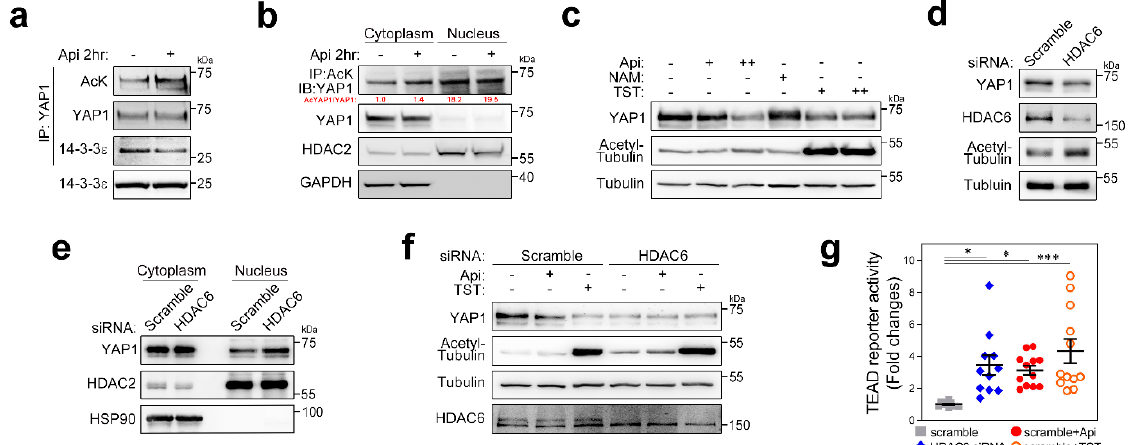
Figure 3. Acetylation governs YAP1 shuttling into the nucleus. ( a ) Apicidin induced acetylation on YAP1. Short-term (2 h) incubation of YAP1 augmented the acetylation level of YAP1 without alteration of YAP1 amounts, which allowed dissociation of YAP1 from the 14-3-3 molecule that tethered YAP1 in the cytoplasm. ( b ) YAP1 acetylation in response to 2 h of treatment with apicidin took place in the cytoplasm, but most acetyl-YAP1 was enriched in the nucleus. HDAC2 shows the nuclear fraction, whereas GAPDH represents cytoplasmic components. ( c ) Cytosolic HDAC(s) might participate in YAP1 acetylation. Tubastatin A phenocopied apicidin-dependent YAP1 degradation. Overnight treatment with Tubastatin A successfully reduced endogenous YAP1 as strongly as did treatment with apicidin, while nicotinamide failed to do so. Acetyl-tubulin delineated cytosol HDAC inhibition. Note that apicidin also induced tubulin acetylation slightly. ( a , e ) HDAC6 regulated YAP1 acetylation. Three days of knocking down with siRNA against HDAC6 significantly reduced YAP1 in the hTERT-MSCs ( d ), while 1 day of incubation after siRNA transfection accelerated nuclear localization of YAP1 (fourth lane) ( e ). HDAC2 depicts the nuclear fraction and HSP90 the cytoplasmic fraction. ( f ) HDAC6 mainly governs the fate of YAP1. Acute degradation of YAP1 was further tested in the absence of HDAC6. Both apicidin and Tubastatin A degraded YAP1, which was not observed when HDAC6 was removed (fourth, fifth, and sixth lane). HDAC6 siRNA itself reduced YAP1, but further loss of YAP1 by either apicidin or Tubastatin A was not detected. ( g ) Acetylation dynamics of YAP1 potentiated TEAD reporter activity. Nuclear translocalization by acetylation of YAP1, HDAC6 siRNA, apicidin, or Tubastatin A activated the TEAD reporter, which represents the Hippo signal. One-way analysis of variance with Tukey’s honestly significant difference (HSD) post hoc test. * p < 0.05, *** p < 0.001. Abbreviations: AcK, acetyl-lysine; NAM, nicotinamide; TST, Tubastatin A.